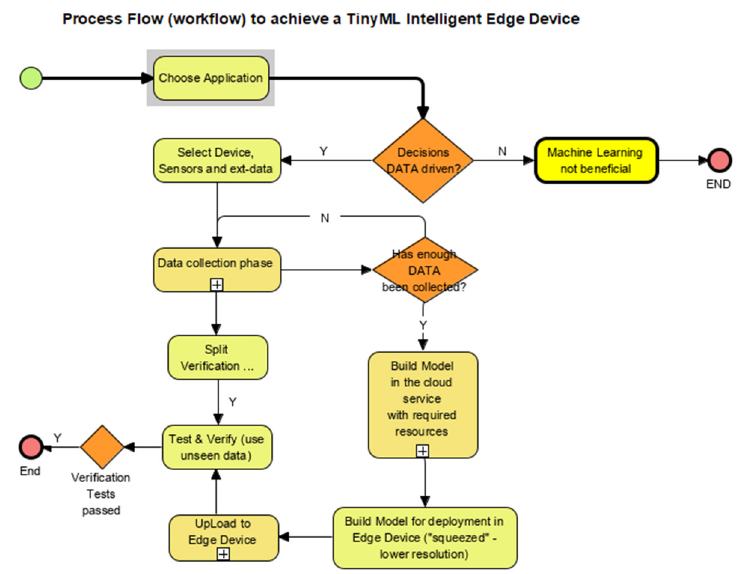
Figure 14. Typical workflow to deploy TinyML.